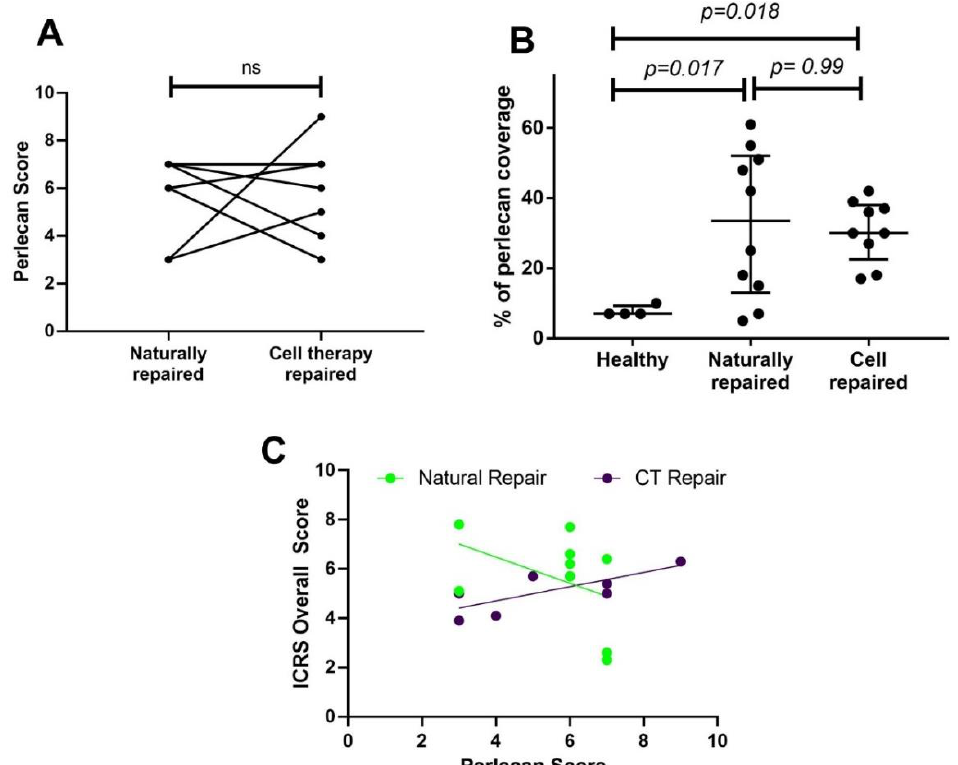
Figure 3. Analysis of tissue morphology and perlecan staining. ( A ) The perlecan immunohistochemistry score gives a general idea of the localisation (pericellular, non-pericellular, mixed) of perlecan in the deep, middle and superficial zones of cartilage. The zones were scored as 0 = no staining, 1 = pericellular staining, 2 = mixture of pericellular and matrix staining, or 3 = matrix staining. The final perlecan score shown here is the summation of the scores for the three zones in each sample. No difference was found between the donor-matched natural and cell therapy repaired tissues. Data show the median with interquartile range. ( B ) Threshold image analysis confirmed a higher percentage of perlecan staining in naturally repaired and CT repaired cartilage than in health cartilage. Perlecan was significantly more prominent in the repair tissues compared to controls. ( C ) Regression analysis showed a positive correlation between the ICRS score and perlecan immunohistochemical score ( r = 0.75, p = 0.03) for cell therapy repaired, but not naturally repaired tissues ( r = −0.4, p = 0.25).